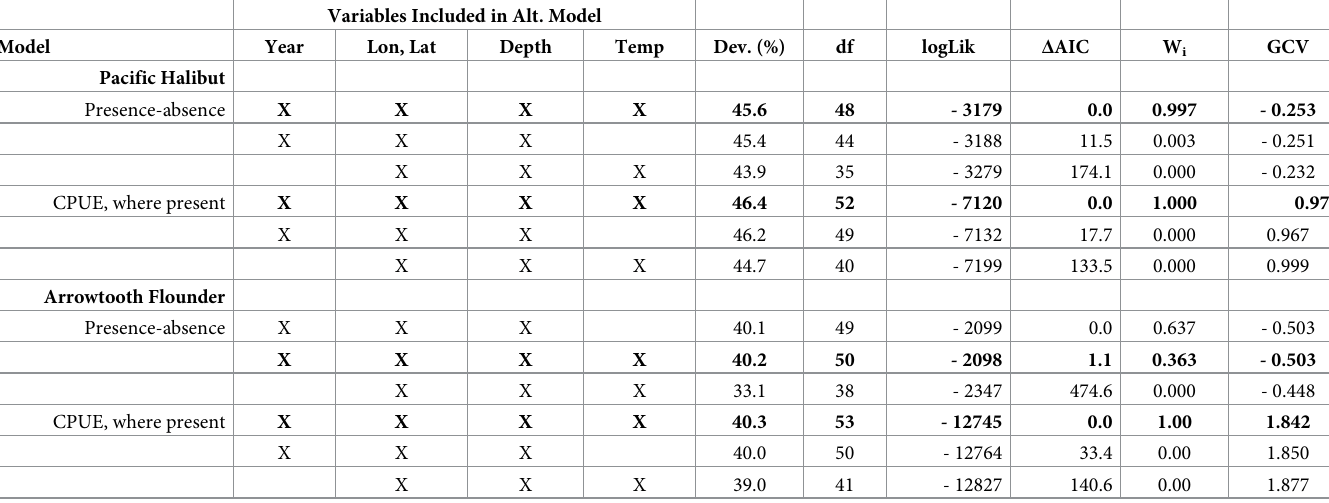
Table 3. Results for the top three models, by species and response type (presence-absence, CPUE, where present). Variables Included in Alt.